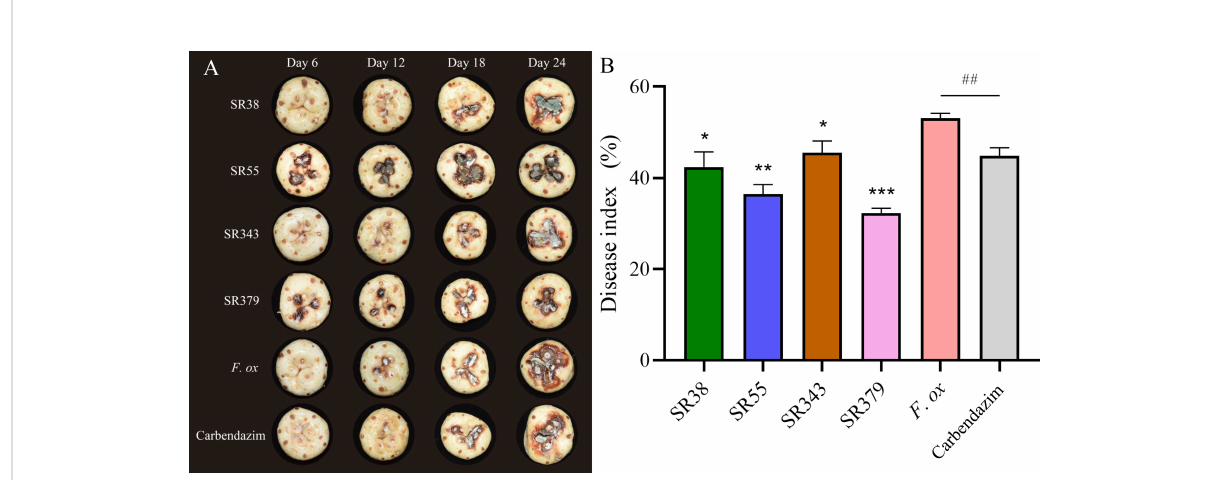
FIGURE 6 Evaluation of corm rot disease resistance of rhizosphere microorganisms in vivo . (A) Photographs of lesions on corm. (B) Histogram of disease index (SR38: Trichoderma yunnanense SR38 + Fusarium oxysporum ; SR55: Talaromyces sp. SR55 + F . oxysporum ; SR343: Enterobacter sp. SR343 + F . oxysporum ; SR379: Burkholderia gladioli SR379 + F . oxysporum ; F. ox : Sterile medium + F. oxysporum ; and Carbendazim: 0.125% carbendazim solution + F. oxysporum ) (group signi fi cance is indicated by * or # : ∗ p < 0.05, ∗∗ p < 0.01, ∗∗∗ p < 0.001, ## p < 0.01).